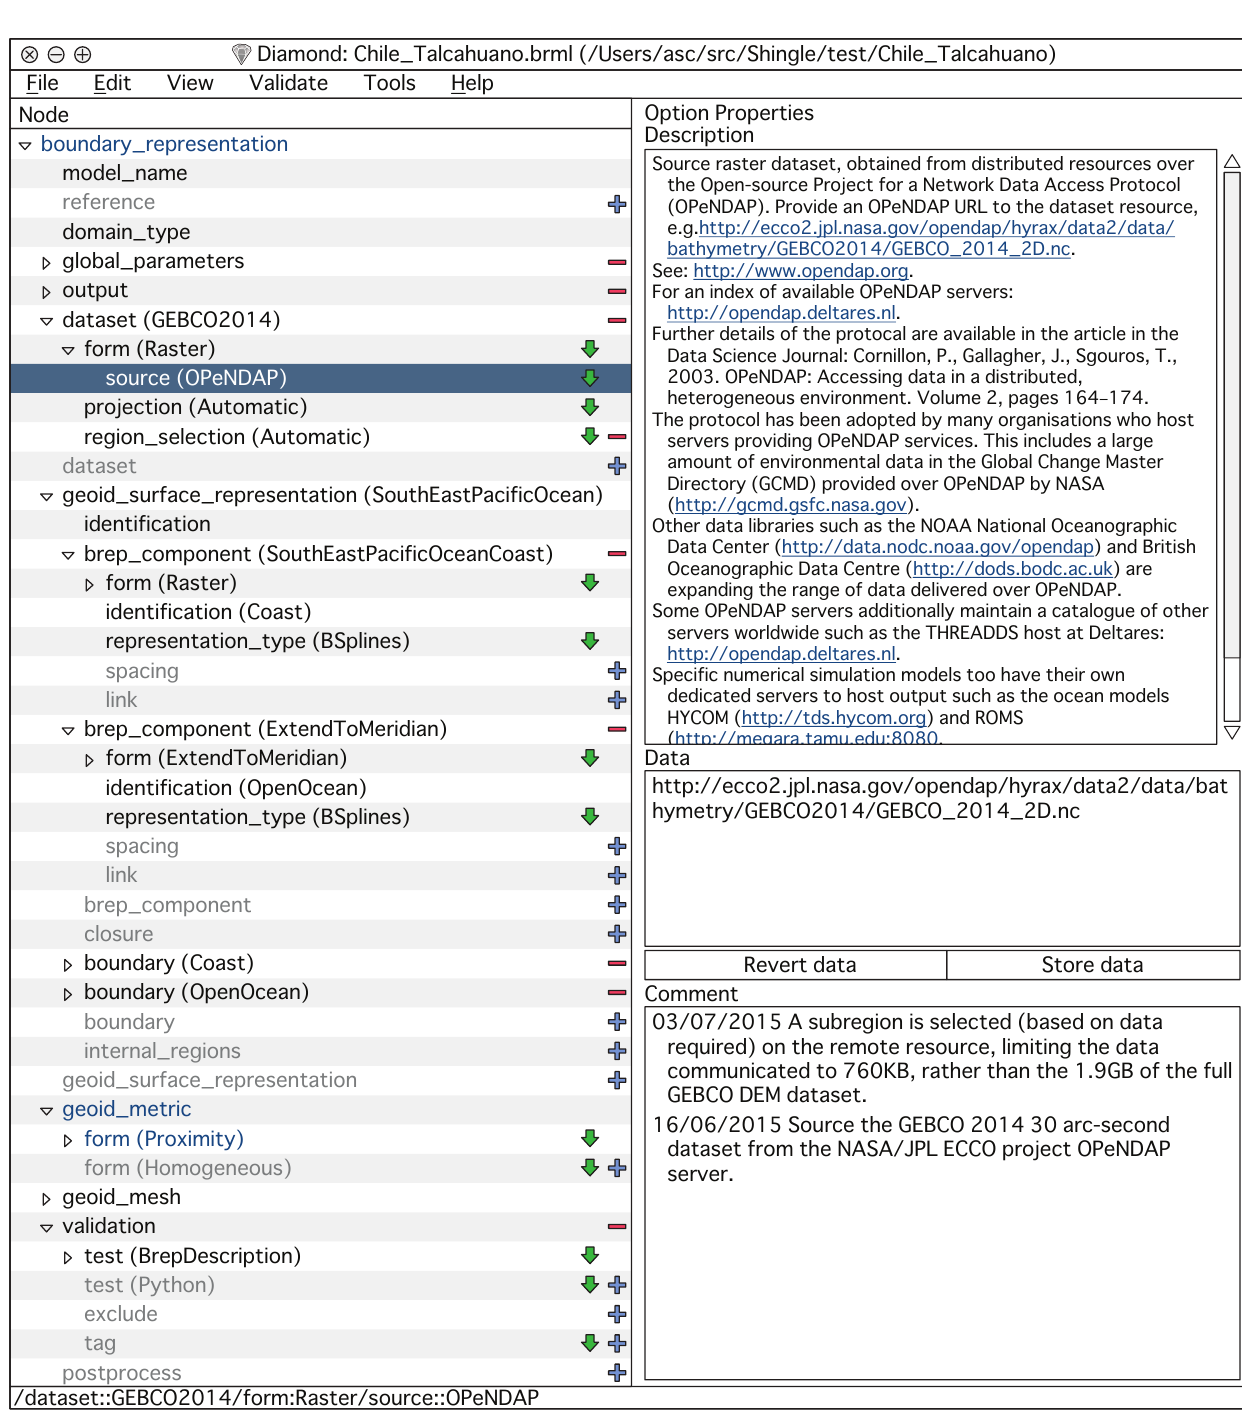
Figure 4. An example view of the Diamond GUI inspecting the hierarchical tree of option parameters that fully constrain the geophysical domain mesh problem. Each node is shown in context on the left, with its option properties presented on the right, including raw data and the possibility to note comments. This is guided by the BRML schema developed and supplied with Shingle, which additionally provides the fuller self-describing option descriptions shown in the top right. Options down the tree highlighted in blue are mandatory and guide the user in defining a complete set of